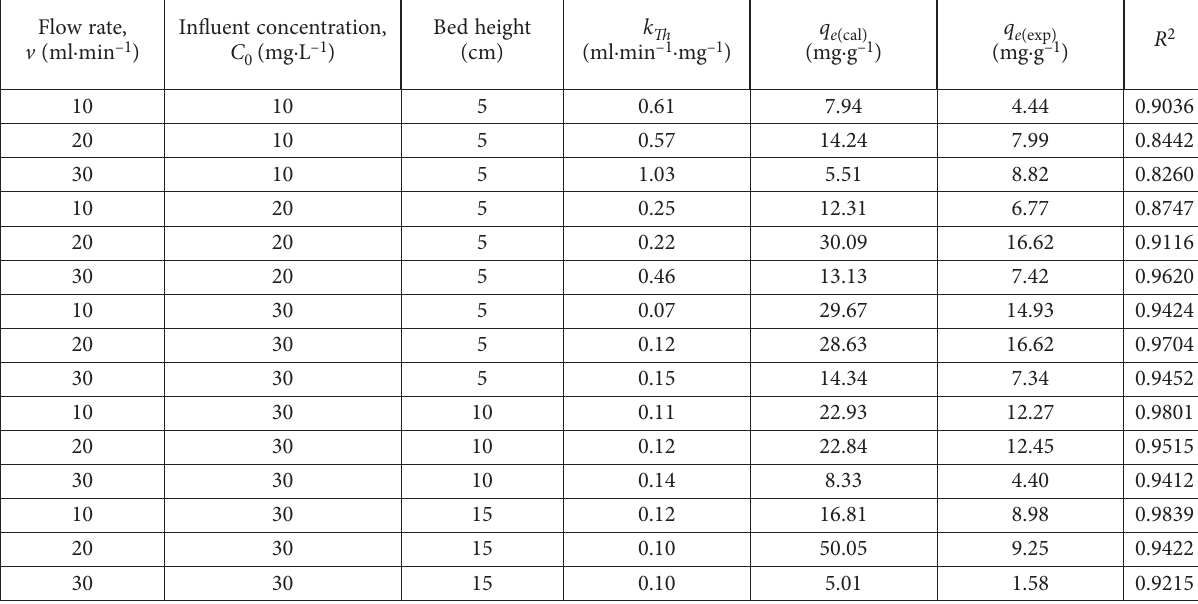
Table 3. Thomas model parameters using linear regression